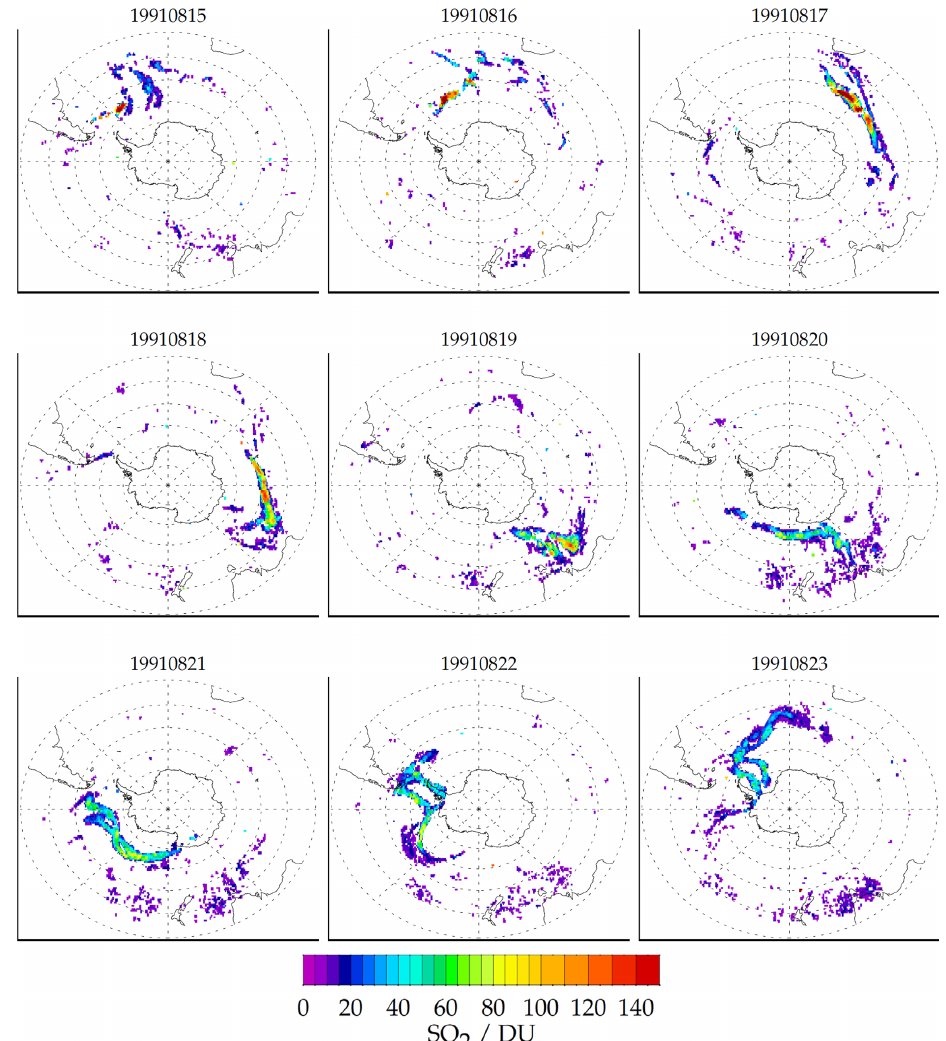
Figure 8. Progression of main erupted plume from 15 August 1991, using all orbits (day and night) from HIRS/2 NOAA 11. The eruption began with smaller amounts emitted from 8 August, which are apparent on the 15th and disassociated from the main plume. The plume’s transport between observations is evident, particularly from 21 August, where it is captured multiple times by multiple swaths. Data have been screened at the 3 σ level (8.1DU) for clarity of the main plume.